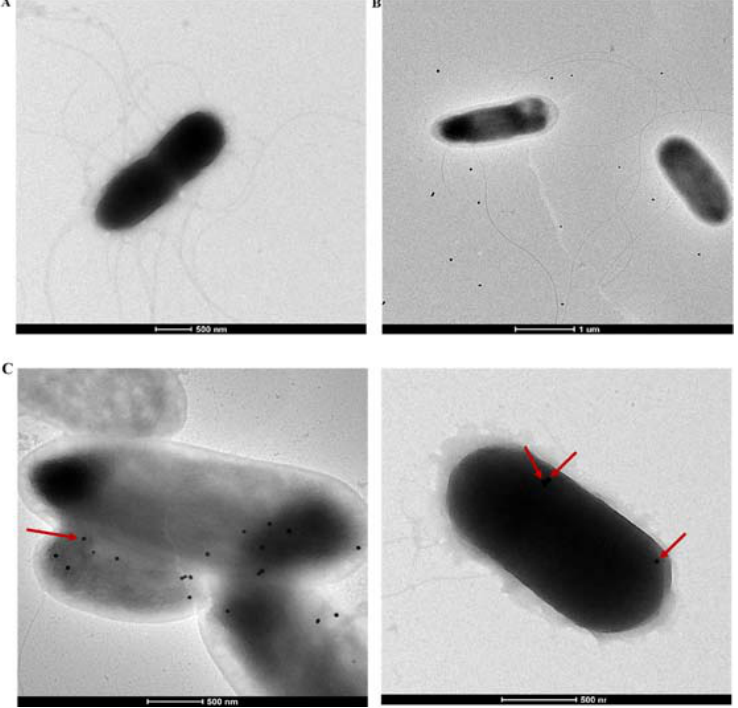
Figure 5. Transmission electron micrographs of C. sakazakii . ( A ) C. sakazakii ; ( B ) C. sakazakii incubated with PEG-grafted Au nanoparticles. The nanoparticles are only observed in the background; ( C ) two micrographs of C. sakazakii incubated with targeted Au nanoparticles stabilized with 100% HS-PEG-biotin and functionalized with biotinylated anti- C. sakazakii IgG via streptavidin. The samples were incubated for 2 h at room temperature and excess free particles thereafter were removed by filtration. The nanoparticles are found bound to the bacteria (identified by red arrows) in a manner consistent with binding to the cell